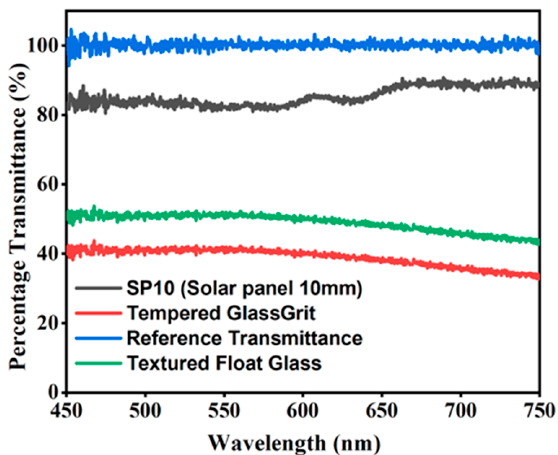
Figure 7. Percentage transmittance for the transparent covering materials.